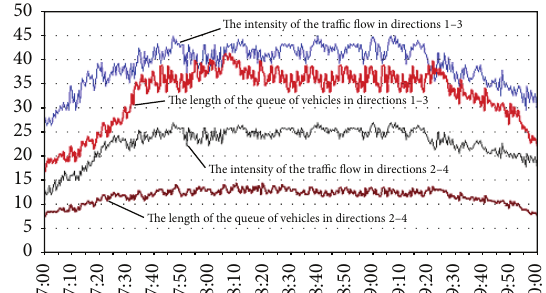
Figure 3: The results of the simulation modeling of the traffic control system with optimum fixed cycle of traffic lights.